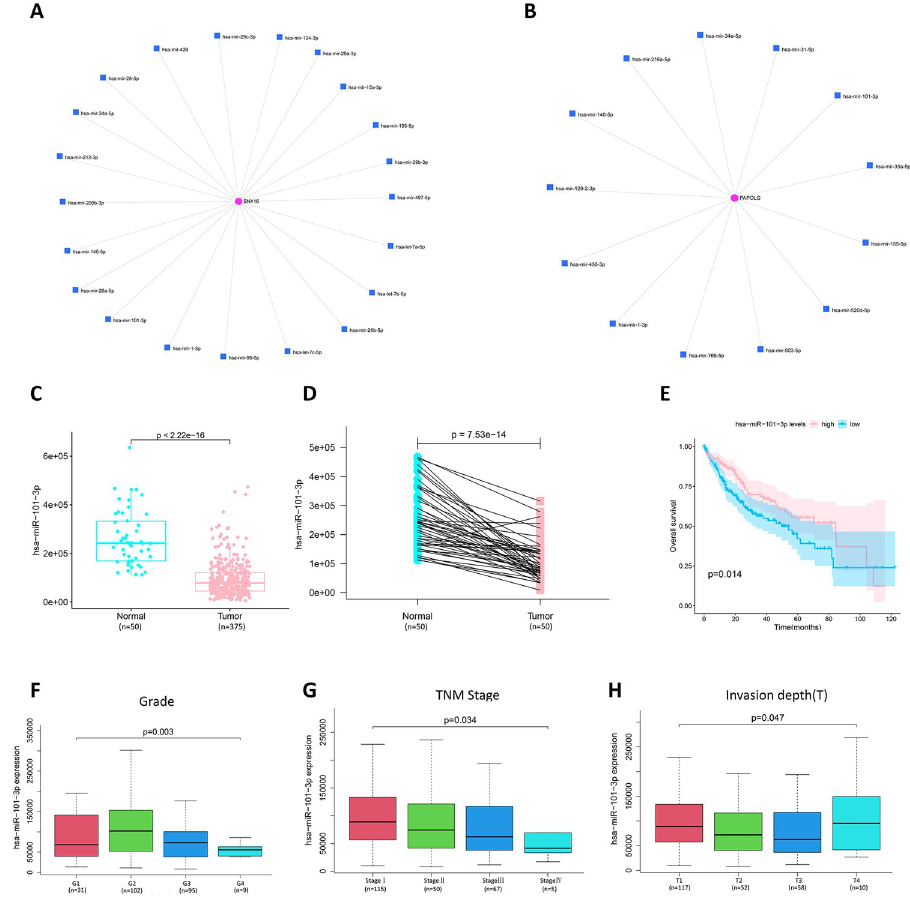
Fig 5. Screening of SNX16 and PAPOLG related miRNA (miR-101-3p) and miR-101-3p for oncogenic effects in HCC. (A) the list of SNX16 related miRNA. (B) the list of PAPOLG related miRNA. (C) Differential expression of miR-101-3p. (D) Differential expression of miR-101-3p in paraneoplastic versus HCC tissues. (E) Analysis of overall survival of miR-101-3p expression in HCC patients. miR-101-3p expression and Grade (F), TNM stage (G), and invasion depth (H) of